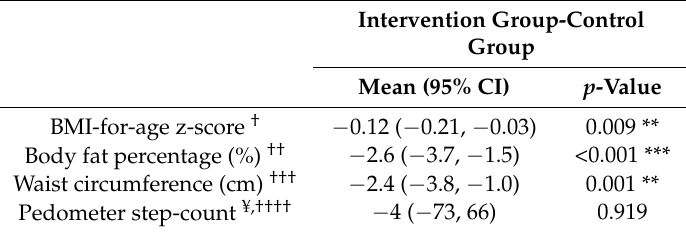
Table 2. Comparison between groups in all outcome measures over the nine months ( n =